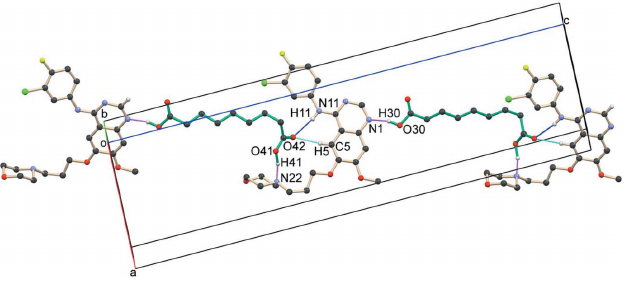
Figure 5 A one-dimensional chain formed by GTB and AA molecules along the ac diagonal via O—H (cid:2)(cid:2)(cid:2) N, N—H (cid:2)(cid:2)(cid:2) O and C—H (cid:2)(cid:2)(cid:2) O hydrogen bonds.